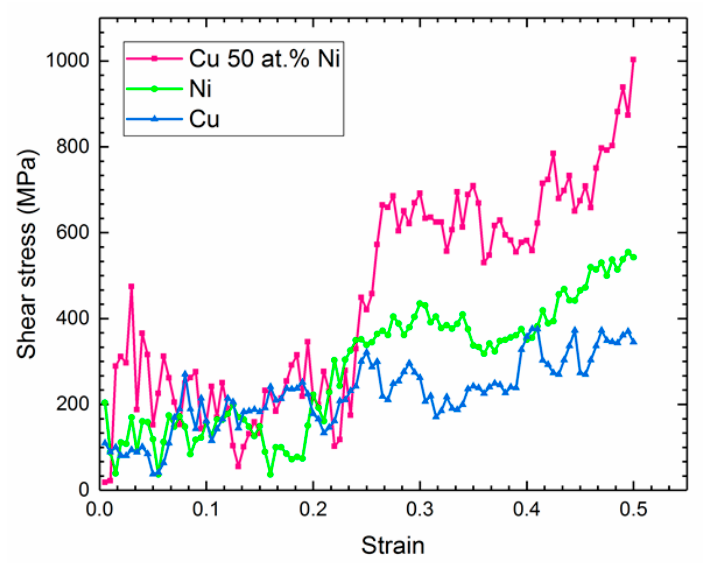
Figure 8. Stress–strain curves of the Cu, Ni, and equimolar Cu-Ni alloy.